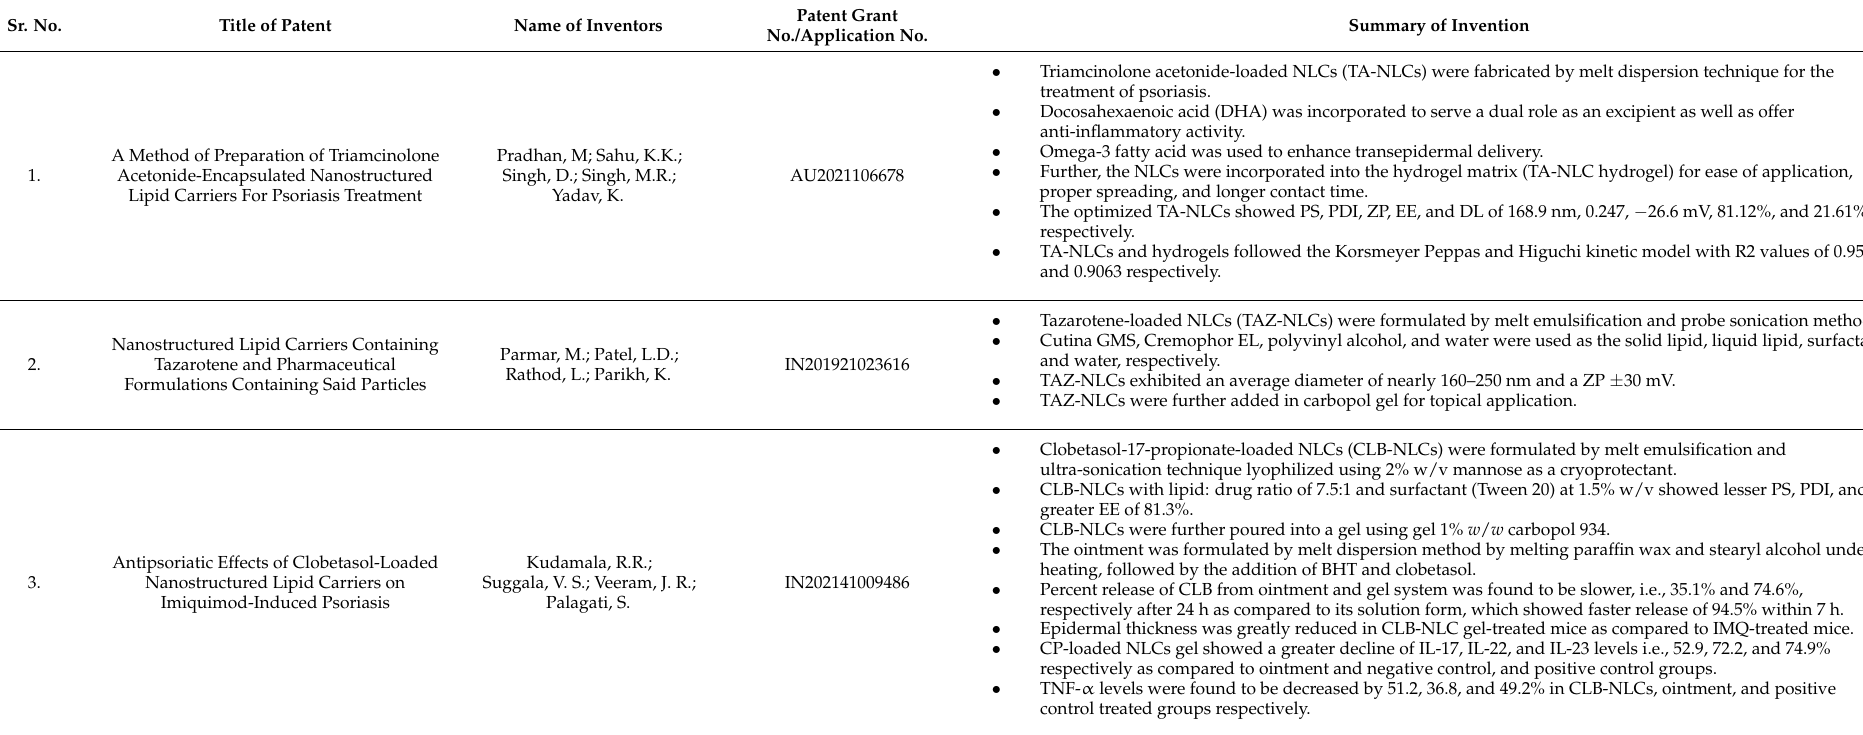
Table 3. Patents relevant to NLCs revealing their therapeutic potential against